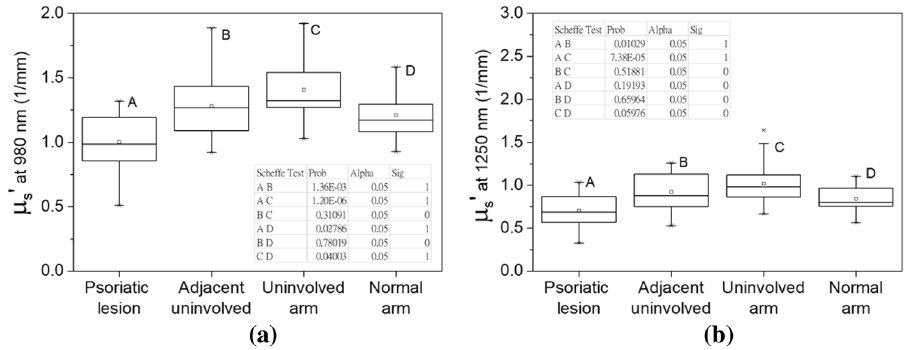
Figure 7. Box-and-whisker plots of reduced scattering coefficients of the four measurement sites at 970 nm and 1300 nm. ( a ) At 970 nm, the P -value of one-way ANOVA was 6.61E−7, indicating that the reduced scattering coefficients were significantly different. Inset table shows Scheff ѐ test P -values between any two groups, and Sig equals to 1 indicates that the means of groups are significantly different at the 0.05 level. ( b ) Box-and-whisker plots of 1300 nm reduced scattering coefficients of the four sites. The P -value of one-way ANOVA was 3.76E−5, indicating that the population means were significantly different. Inset table shows Scheff ѐ test P -values between any two